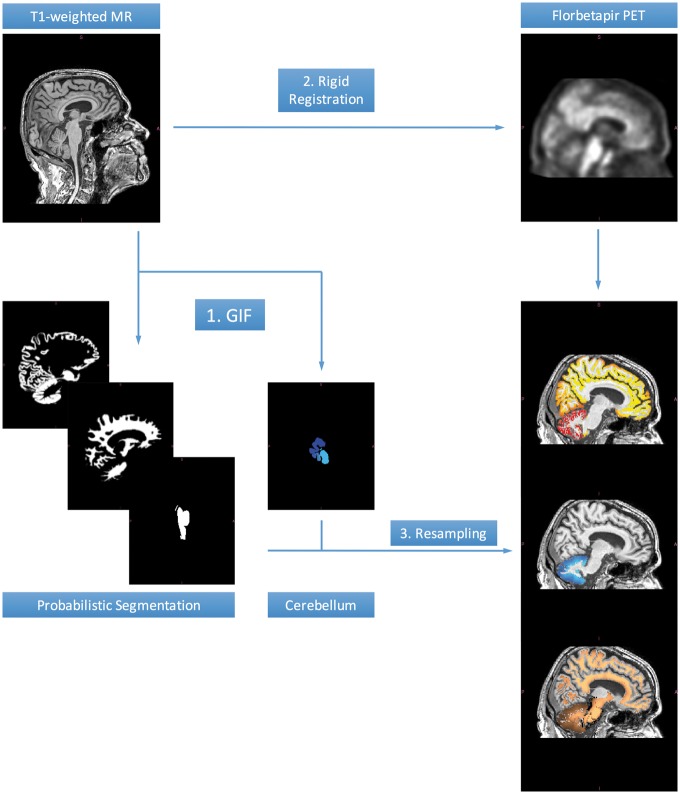

Image processing pipeline for the amyloid load computation. GIF was used to obtain a probabilistic segmentation of the T1-weighted scans into background/skull, grey matter, white matter, CSF, subcortical structures, brainstem/pons and cerebellar nuclei. Each T1-weighted scan was rigidly registered to the closest-in-time florbetapir PET scan using the Aladin algorithm; a cubic spline interpolation scheme in two steps was used to resample the warped T1 image to the space of the closest-in-time lower-resolution PET. The GIF segmentations were resampled to the space of the PET scan, to define two key regions: (i) a cortical target region excluding the cerebellar grey matter; and (ii) a composite reference region comprising white matter, whole cerebellum, brainstem and pons, as proposed by Landau et al. (2015).